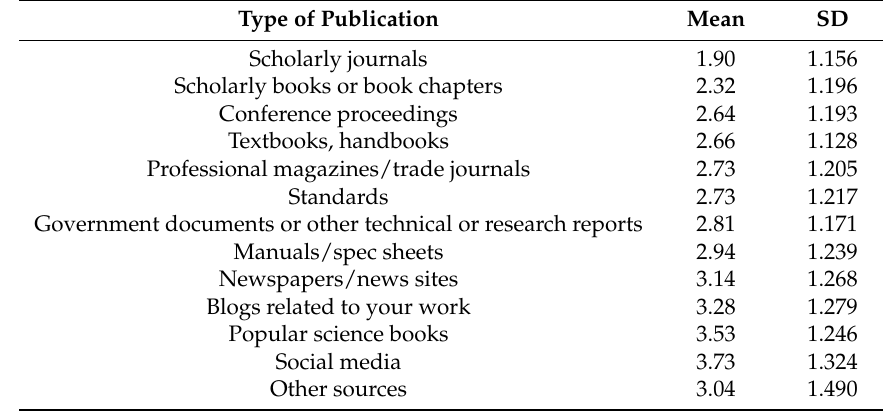
Table 4. Importance of types of publications to respondents’ work (1 = absolutely essential; 2 = very important; 3 = important; 4 = somewhat important; to 5 = not at all important).